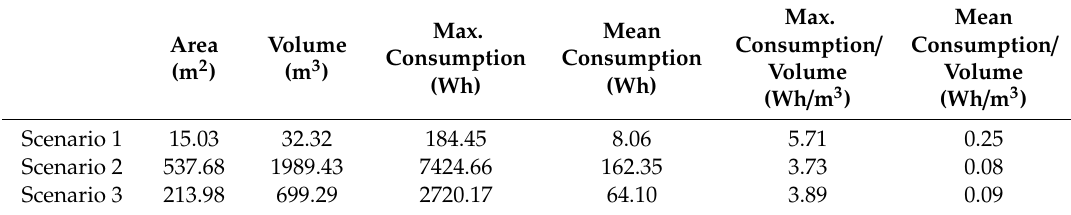
Table 6. From the heating system simulation with the manually generated